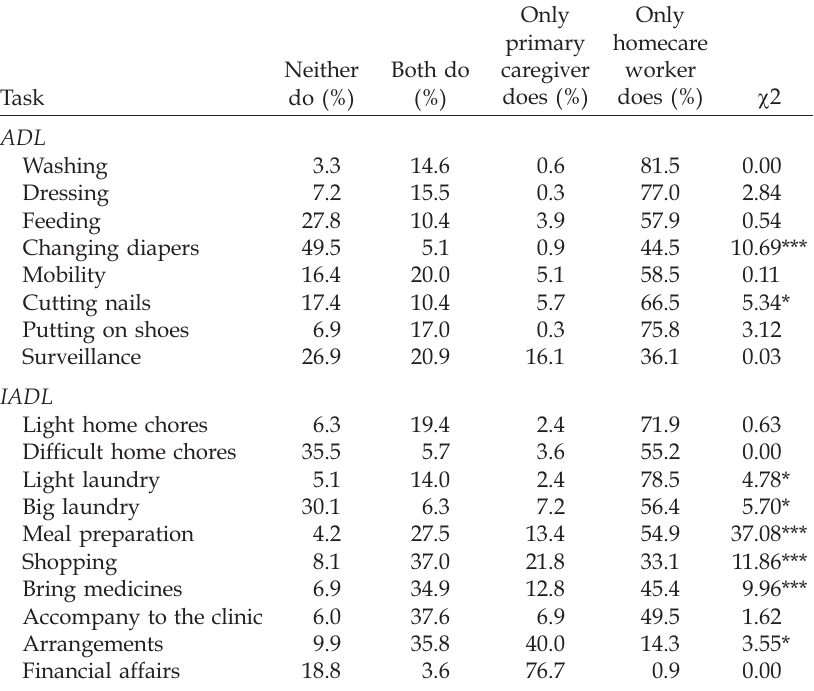
Table 1. Tasks performed by primary caregi v ers and by migrant li v e-in homecare workers